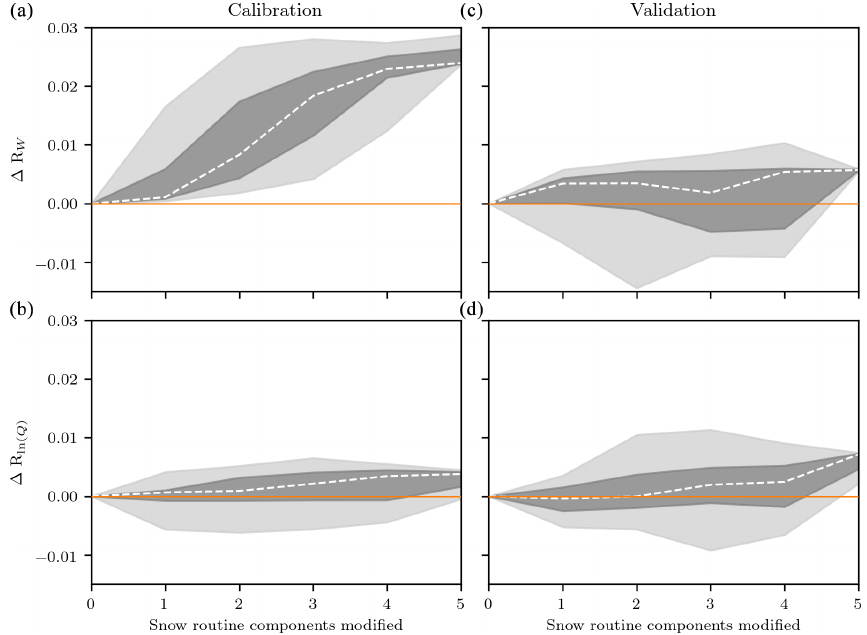
Figure 7. Median relative model performance with respect to HBV across all catchments for the 64 considered snow routine structures sorted by an increasing number of modifications. Model simulations against snow water equivalent are presented in (a, c) , while those against logarithmic stream runoff are shown in (b, d) . Model calibration is presented in (a, b) and model validation in (c, d) . The dashed line represents the median value across all catchments, while the grey fields represent the minimum to maximum (light grey) and 25th to 75th percentiles (dark grey). The relative model performance of HBV is highlighted with a solid orange